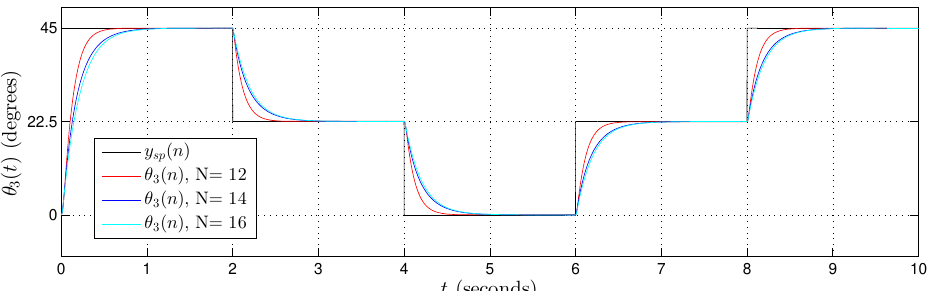
Figure 24. Validation results from the proposed Takagi–Sugeno Fuzzy-PI hardware. Simulation trajectory for θ 3 ( t ) with θ 3 ( n ) using N = { 12,14,16 } bits in the fractional part. Table 6. Angle trajectory changing for set point variables θ sp Set